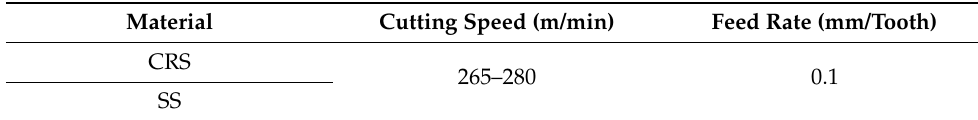
Table 3. Milling parameters used for CRS and